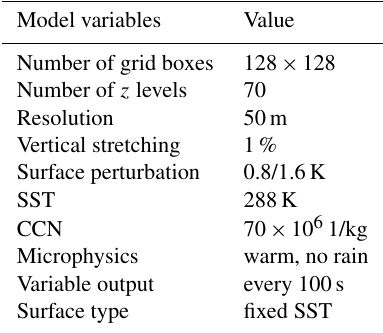
Table 1. Model setup for the single cloud simulations. CCN indi- cates cloud condensation nuclei.